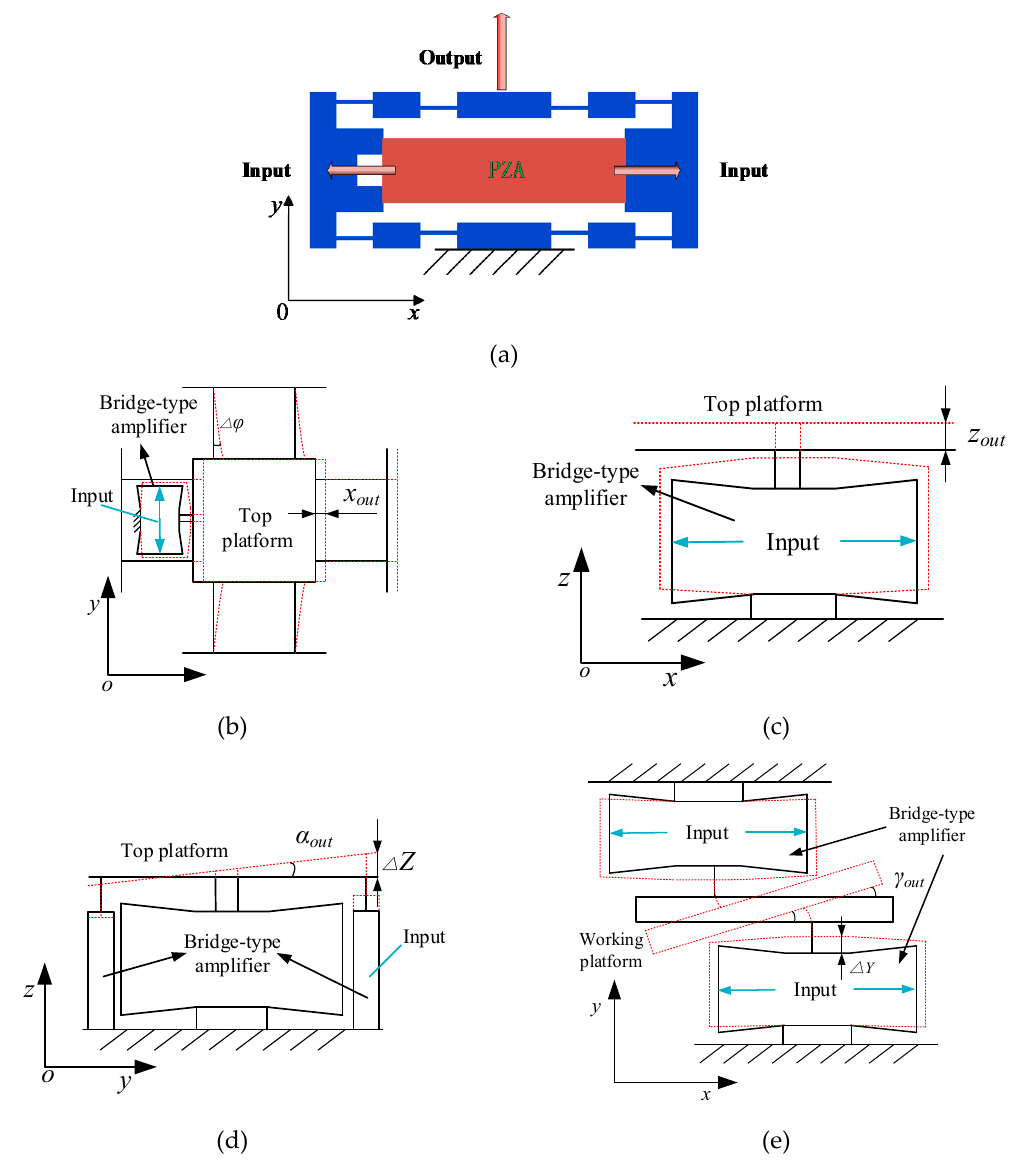
Figure 2. Schematic diagram of the stage: ( a ) schematic of the bridge-type amplifier, ( b ) schematic of translation in the X direction, ( c ) schematic of translation in the Z direction, ( d ) schematic of rotation around the X axis and ( e ) schematic of rotation around the Z axis.